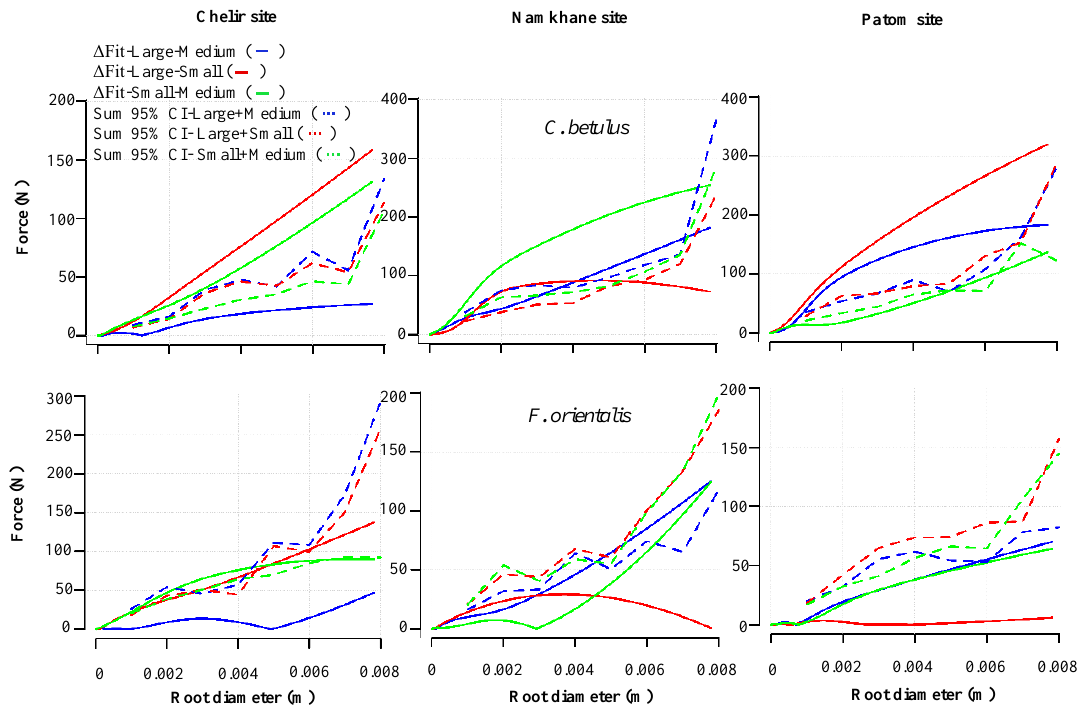
Figure 9. Calculation of difference between the fitting curves of tensile force vs. root diameter for the Carpinus betulus and Fagus orientalis within three classes of diameter at breast height (DBH; small = 7.5–32.5 cm; medium = 32.6–57.5; and large = 57.6–82.5 cm) at three study sites (Chelir, Namkhane, Patom).